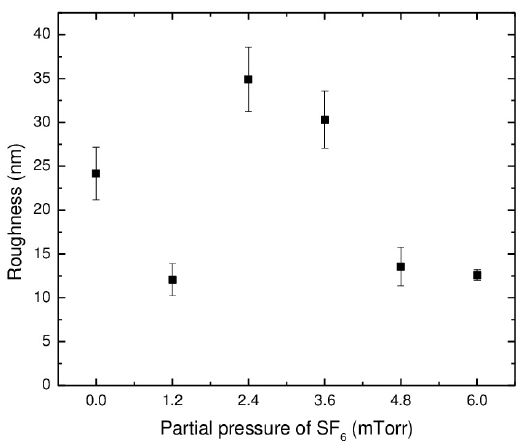
Figure 3. Surface roughness as a function of R